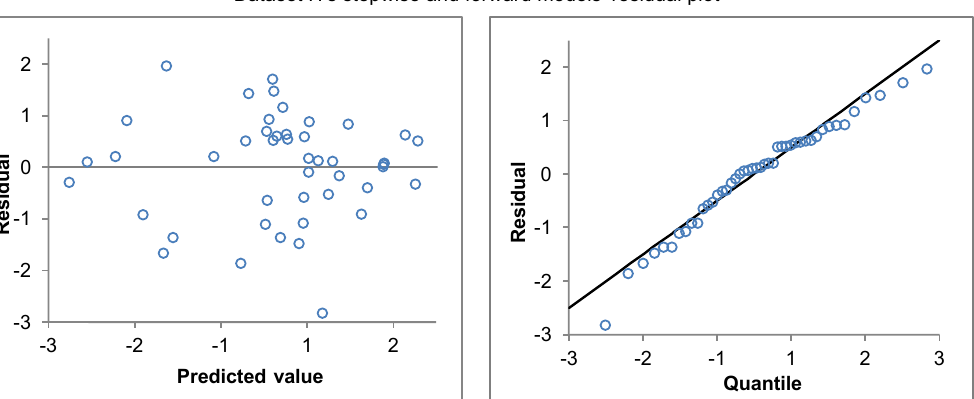
Dataset H’s stepwise and forward models’ residual